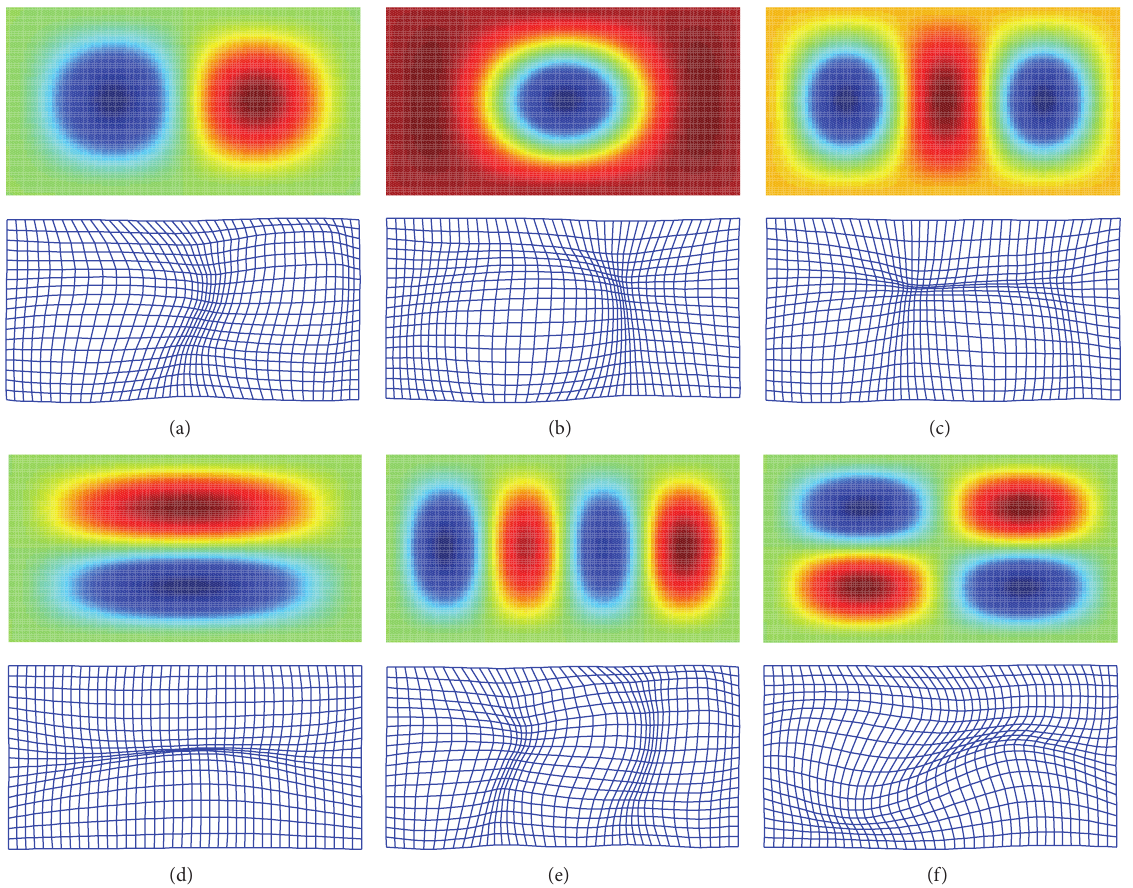
Figure3:Themodeshapes(above:out-of-planemodeshapes;below:in-planemodeshapes)foradoublycurvedshallowshellwithcompletely clamped edges: The (a) first, (b) second, (c) third, (d) fourth, (e) fifth, and (f) sixth mode.